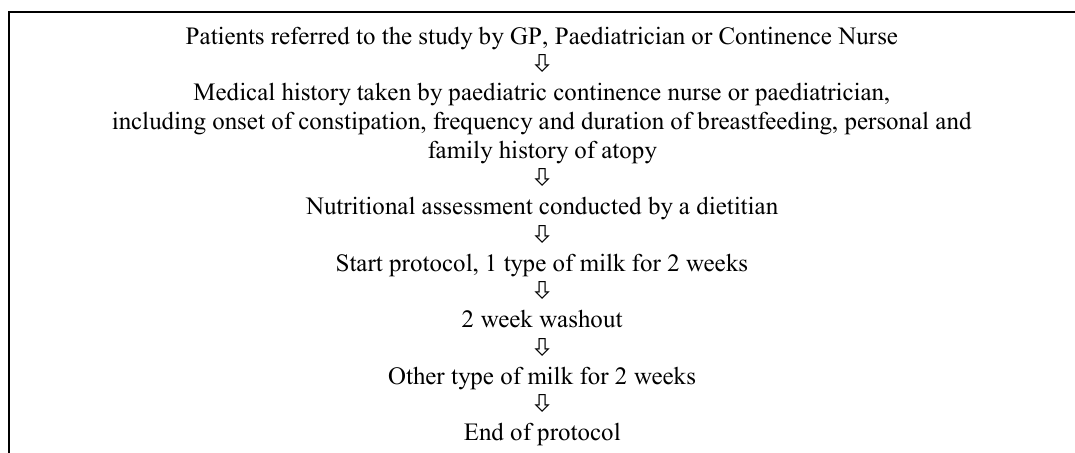
Figure 2. Flowchart of the trial